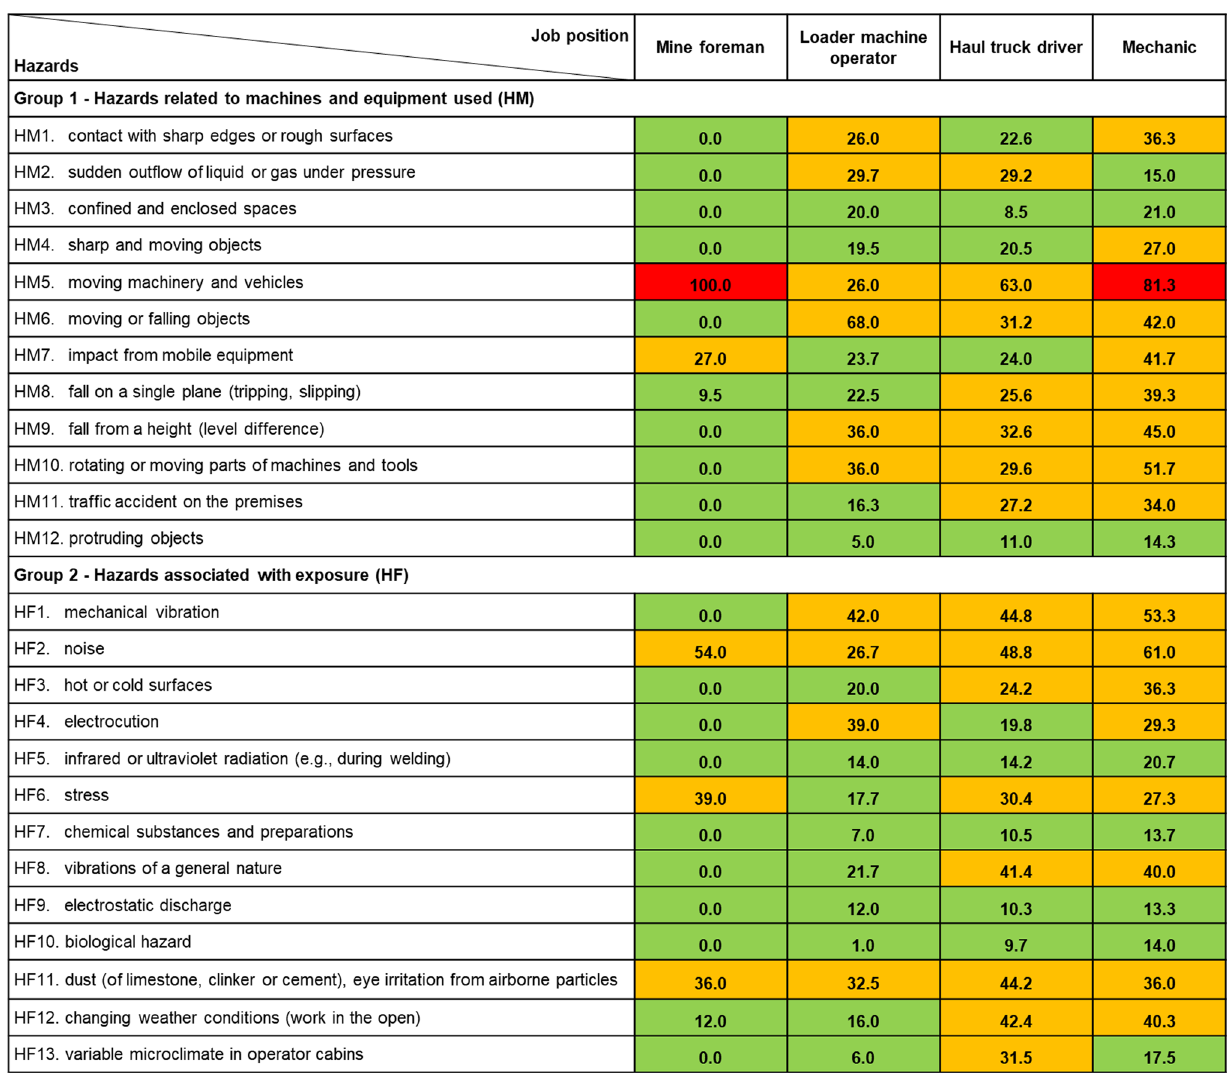
Fig. 4 The results of occupational risk assessment for the analyzed positions—hazards from groups 1 and